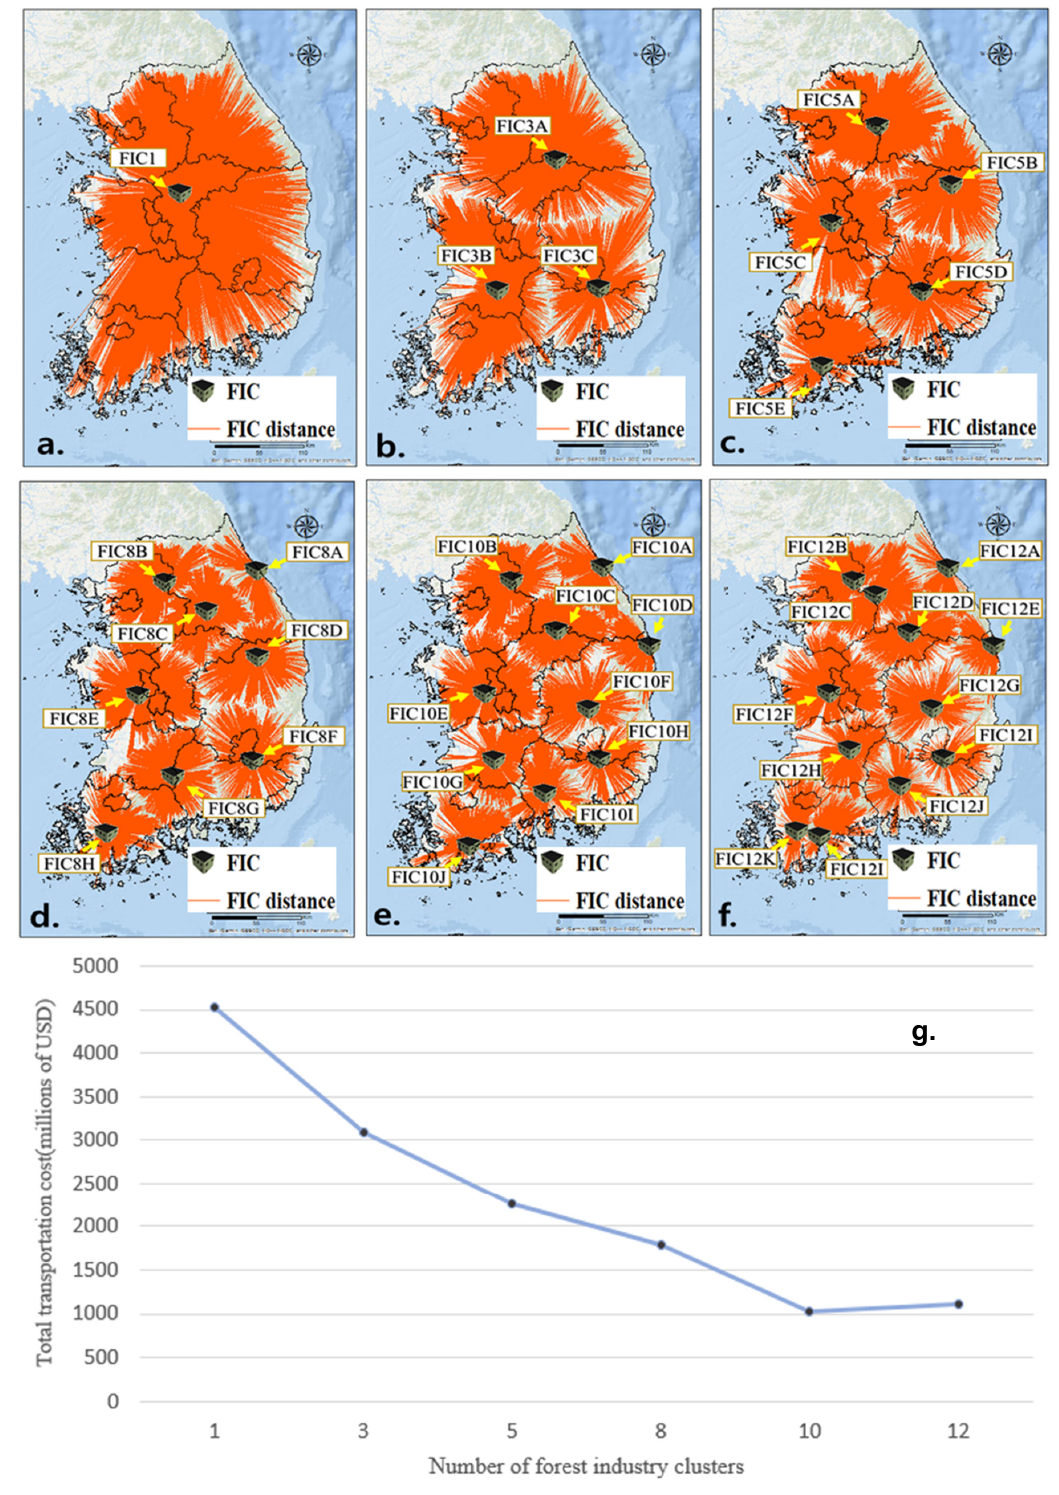
Figure 6. Location and allocation analysis identifying the optimal number and locations for potential forest industry clusters in different scenarios (Each picture indicated the results of Scenario ( a – f ) and red lines indicate connections between facilities and location of forest resources, and white boxes represent the location code of each FIC; ( g ) indicated the variation of total transportation cost with number of plants).